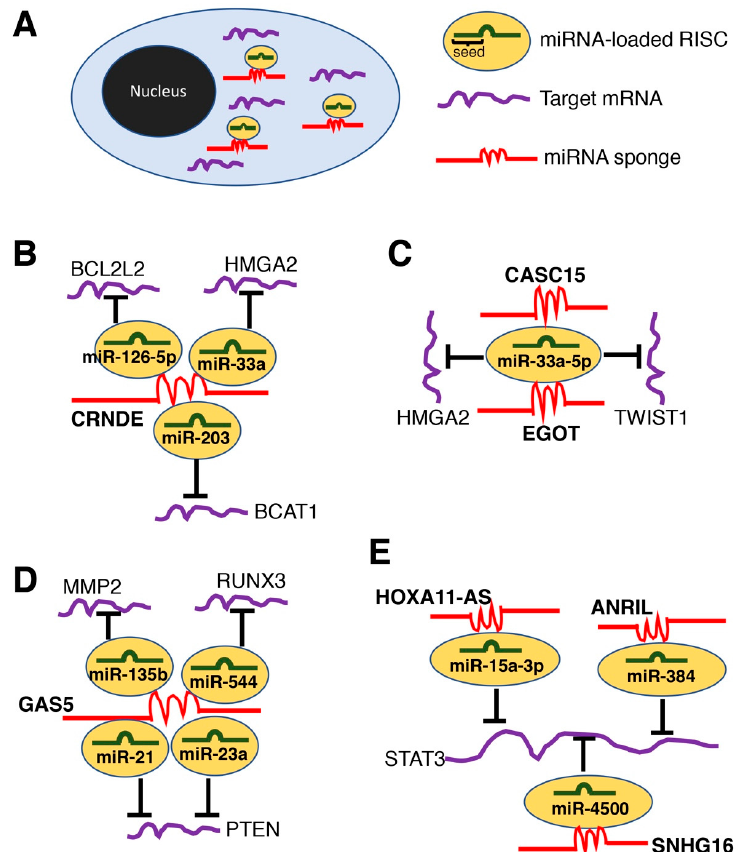
Figure 2. LncRNAs as miRNA sponges. ( A ) A schematic illustration of miRNA sponge mechanism in the cell. RISC, RNA-induced silencing complex. ( B ) The lncRNA colorectal neoplasia differentially expressed ( CRNDE) . ( C ) An example of miRNA being sequestered by two lncRNAs. CASC15 , cancer susceptibility 15; EGOT , eosinophil granule ontogeny transcript; HMGA2 , high mobility group AT-hook 2; TWIST1 , twist family bHLH transcription factor 1. ( D ) The lncRNA growth arrest specific 5 ( GAS5 ). Interestingly, GAS5 sequesters miR-21 and miR-23a , which both target phosphatase and tensin homolog ( PTEN ) mRNA. BCL2L2 , BCL2 like 2; BCAT1 , branched chain amino acid transaminase 1; MMP2 , matrix metallopeptidase 2; RUNX3 , RUNX family transcription factor 3. ( E ) An example of a target mRNA with multiple miRNA binding sites. HOXA11-AS , HOXA11 antisense RNA; ANRIL , antisense non-coding RNA in the INK4 locus; SNHG16 , small nucleolar RNA host gene 16; STAT3 , signal transducer and activator of transcription